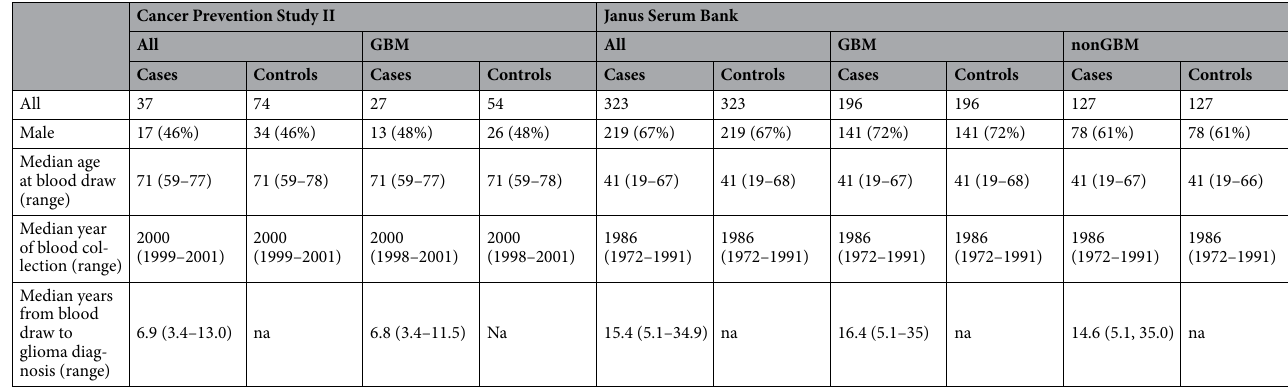
Table 1. Descriptive characteristics of nested case–control studies of Polyomaviruses and glioma risk: Cancer Prevention Study II and Janus Serum